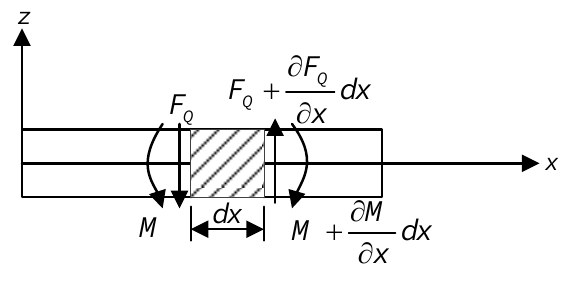
Figure 3. A Timoshenko beam and its infinitesimal section.